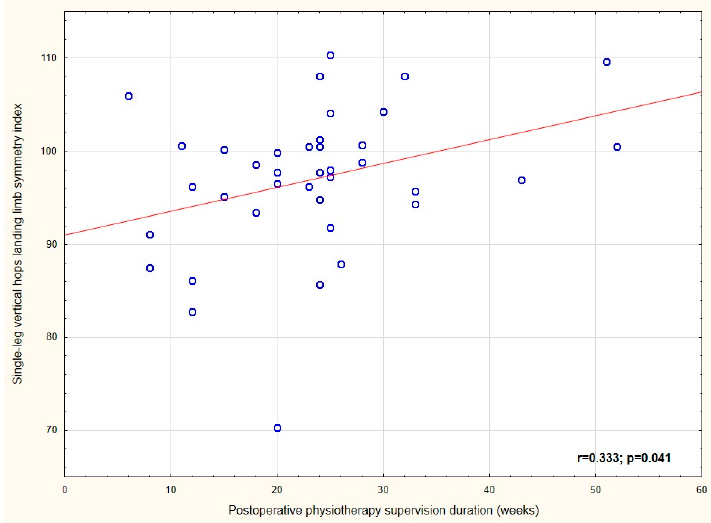
Figure 7. A statistically significant but weak positive correlation indicated that the higher limb symmetry index of vGRF BM during the single-leg vertical hop landing is associated with a longer duration of postoperative physiotherapy supervision in patients after ACLR.